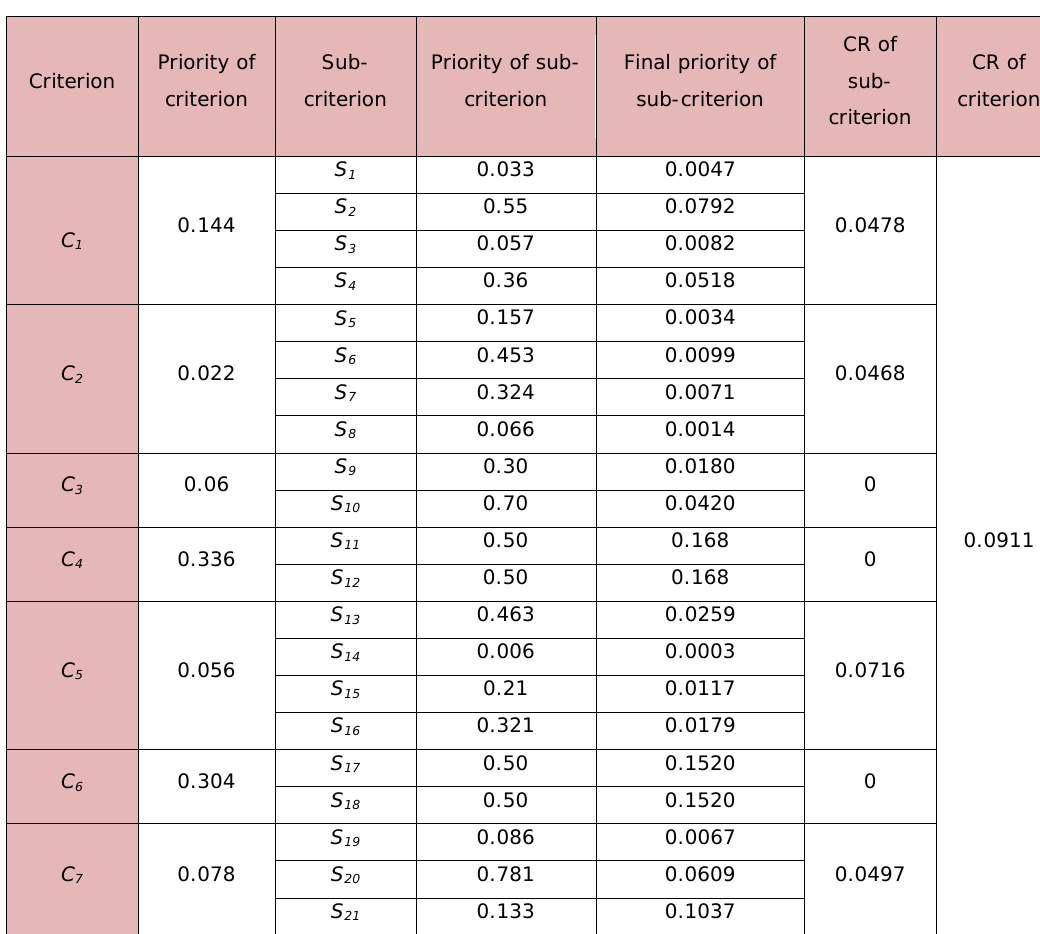
Table 10. “Priority and consistency ratios for the evaluation of m-commerce”.